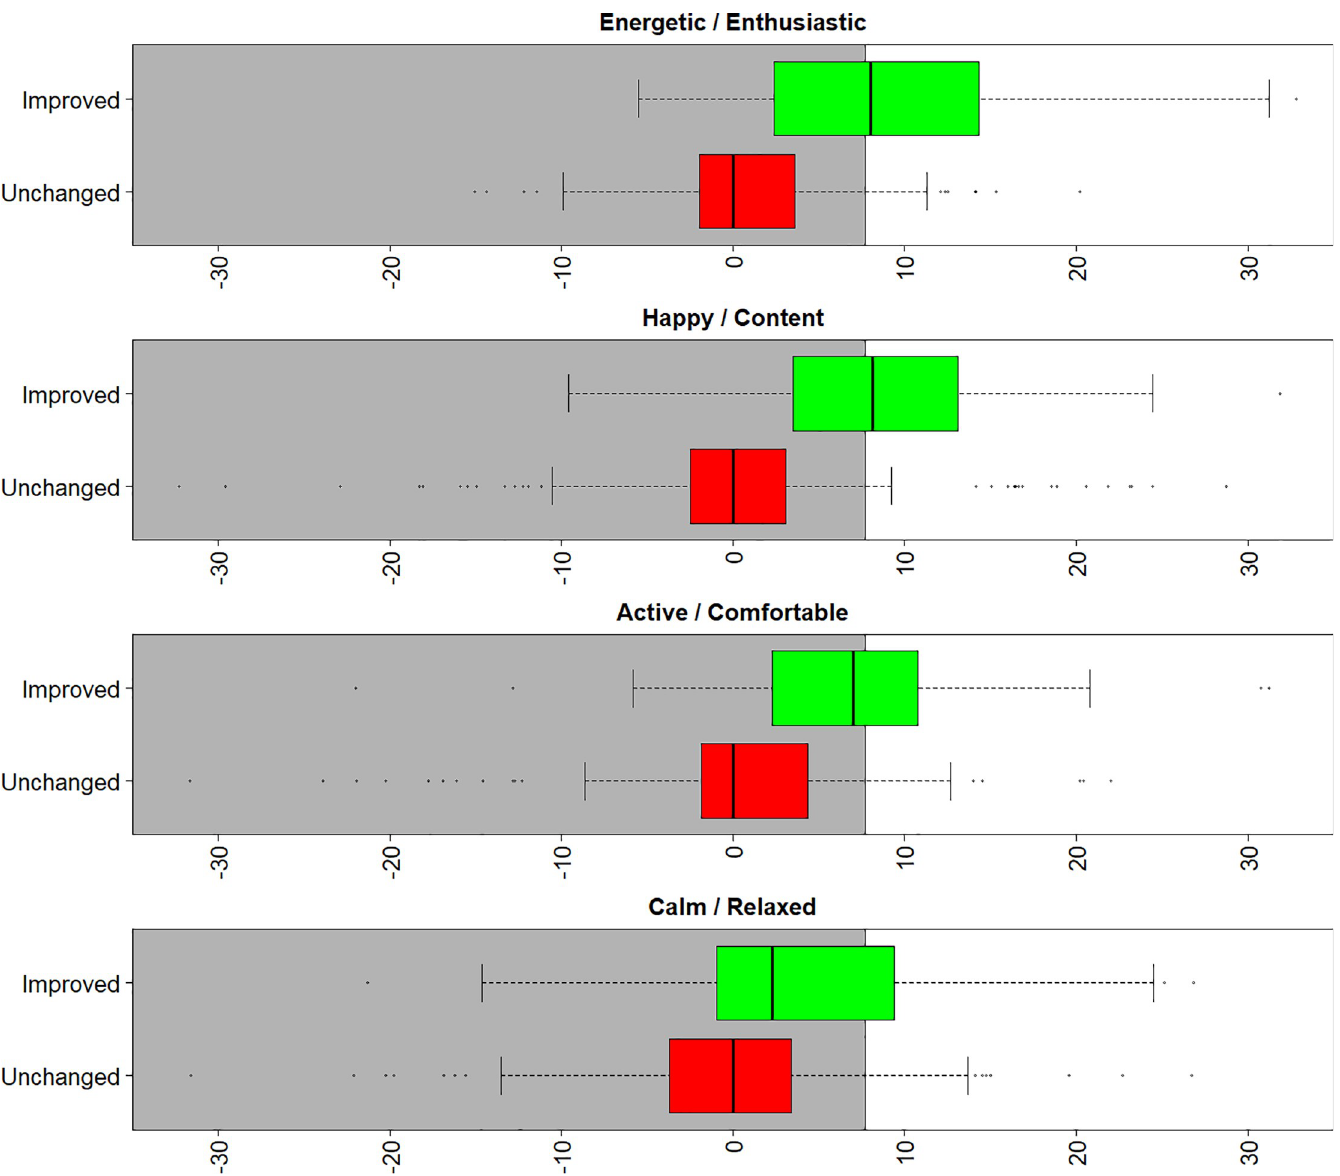
Fig 7. Box plots of the change in the 4 normalised HRQL scores over multiple observations of the same dogs. Differences in the scores are shown as boxplots, where green indicated a dog was reported to have improved and red where no change was observed. The grey area shows where a dog would be classified by MIDconsistent to be unchanged and white shows where the classification would be of improvement: the cut-off for this is 7.7 (Table